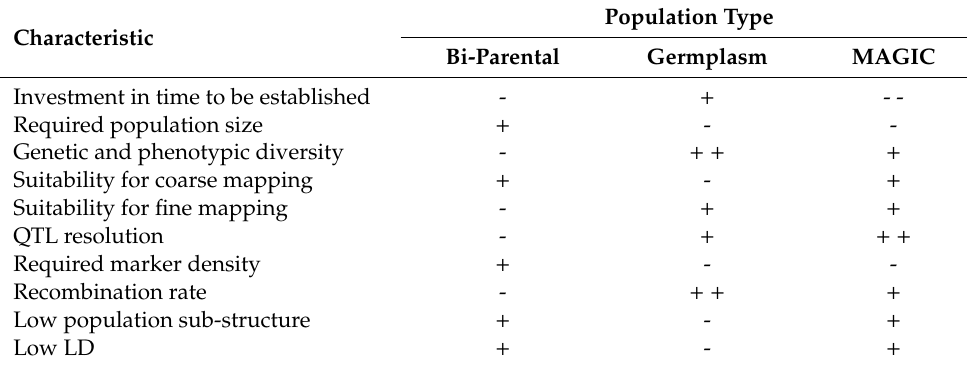
Table 1. Advantages ( + ) and limitations (-) of linkage analysis (bi-parental populations), association mapping (GWAS) using germplasm populations, and multi-parent advanced generation inter-cross (MAGIC) for di ff erent characteristics of interest for their development and use. QTL: quantitative trait